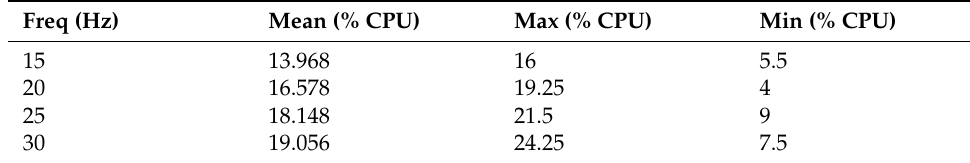
Table 3. Low-resolution CPU usage values.